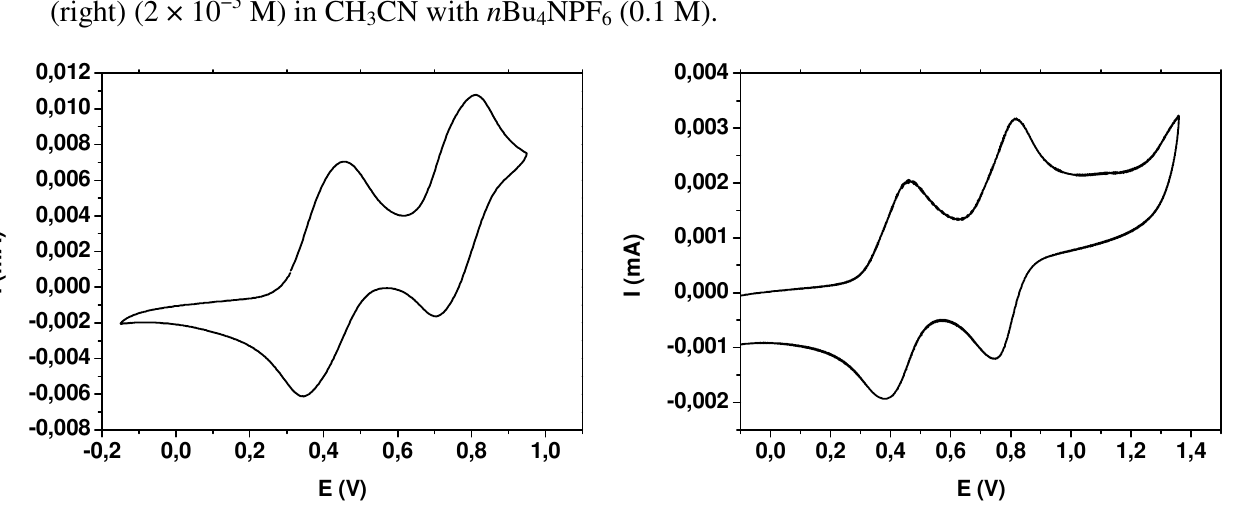
Figure 7. Cyclic voltammograms of both the pincer ( 3 ) (left) and of the zinc complex ( 4 ) (right) (2 × 10 −5 M) in CH